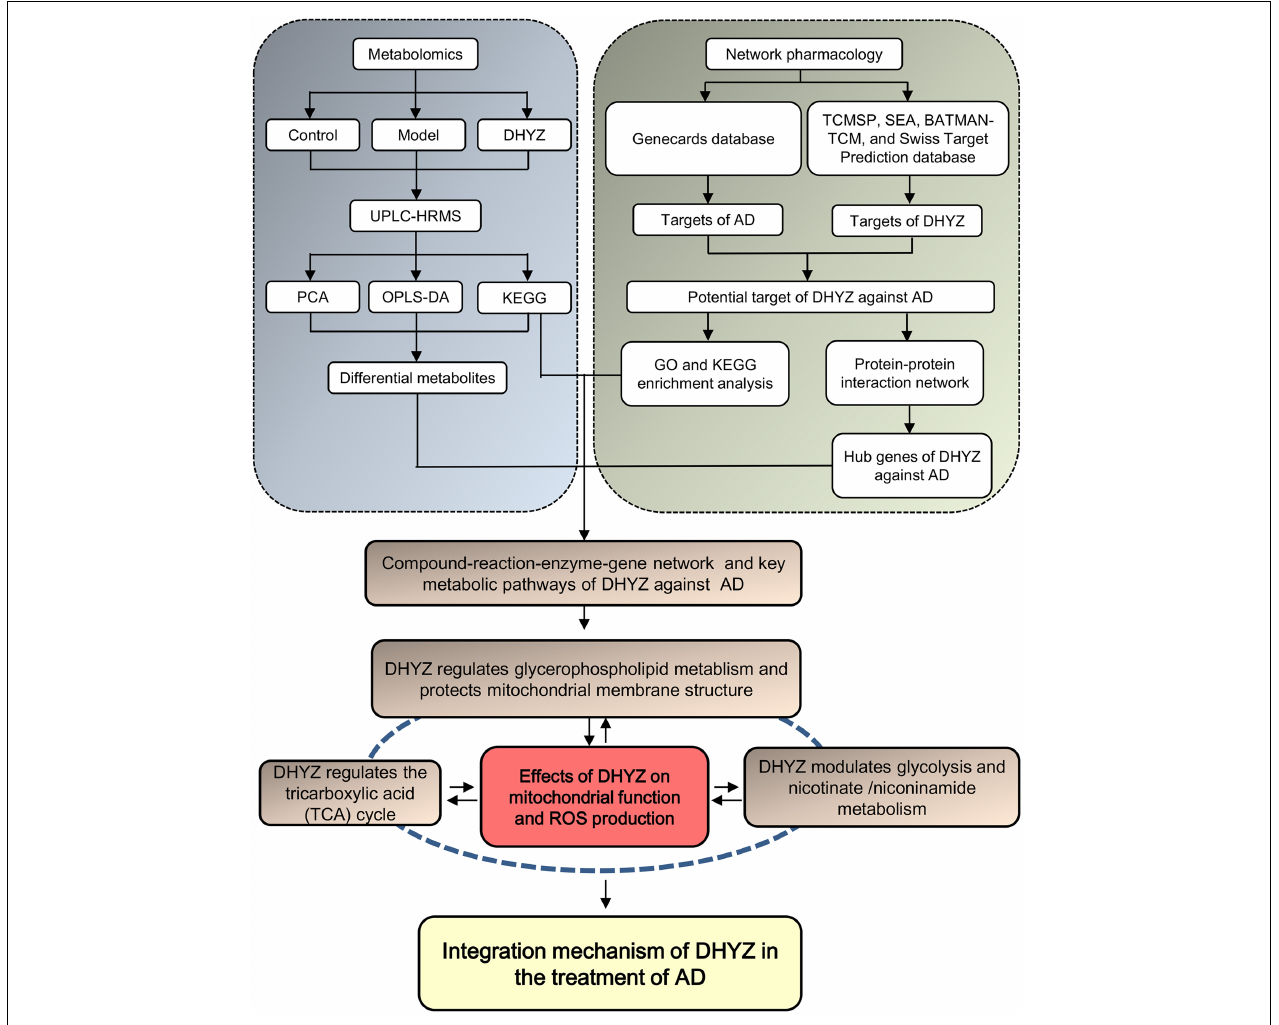
FIGURE 1 | Schematic diagram of the integrated study of DHYZ against AD combining urine metabonomics and network